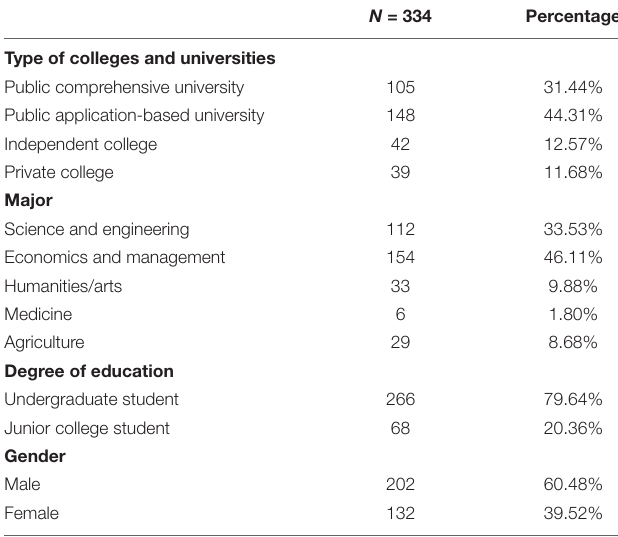
TABLE 1 | Distribution of the sampled firms.